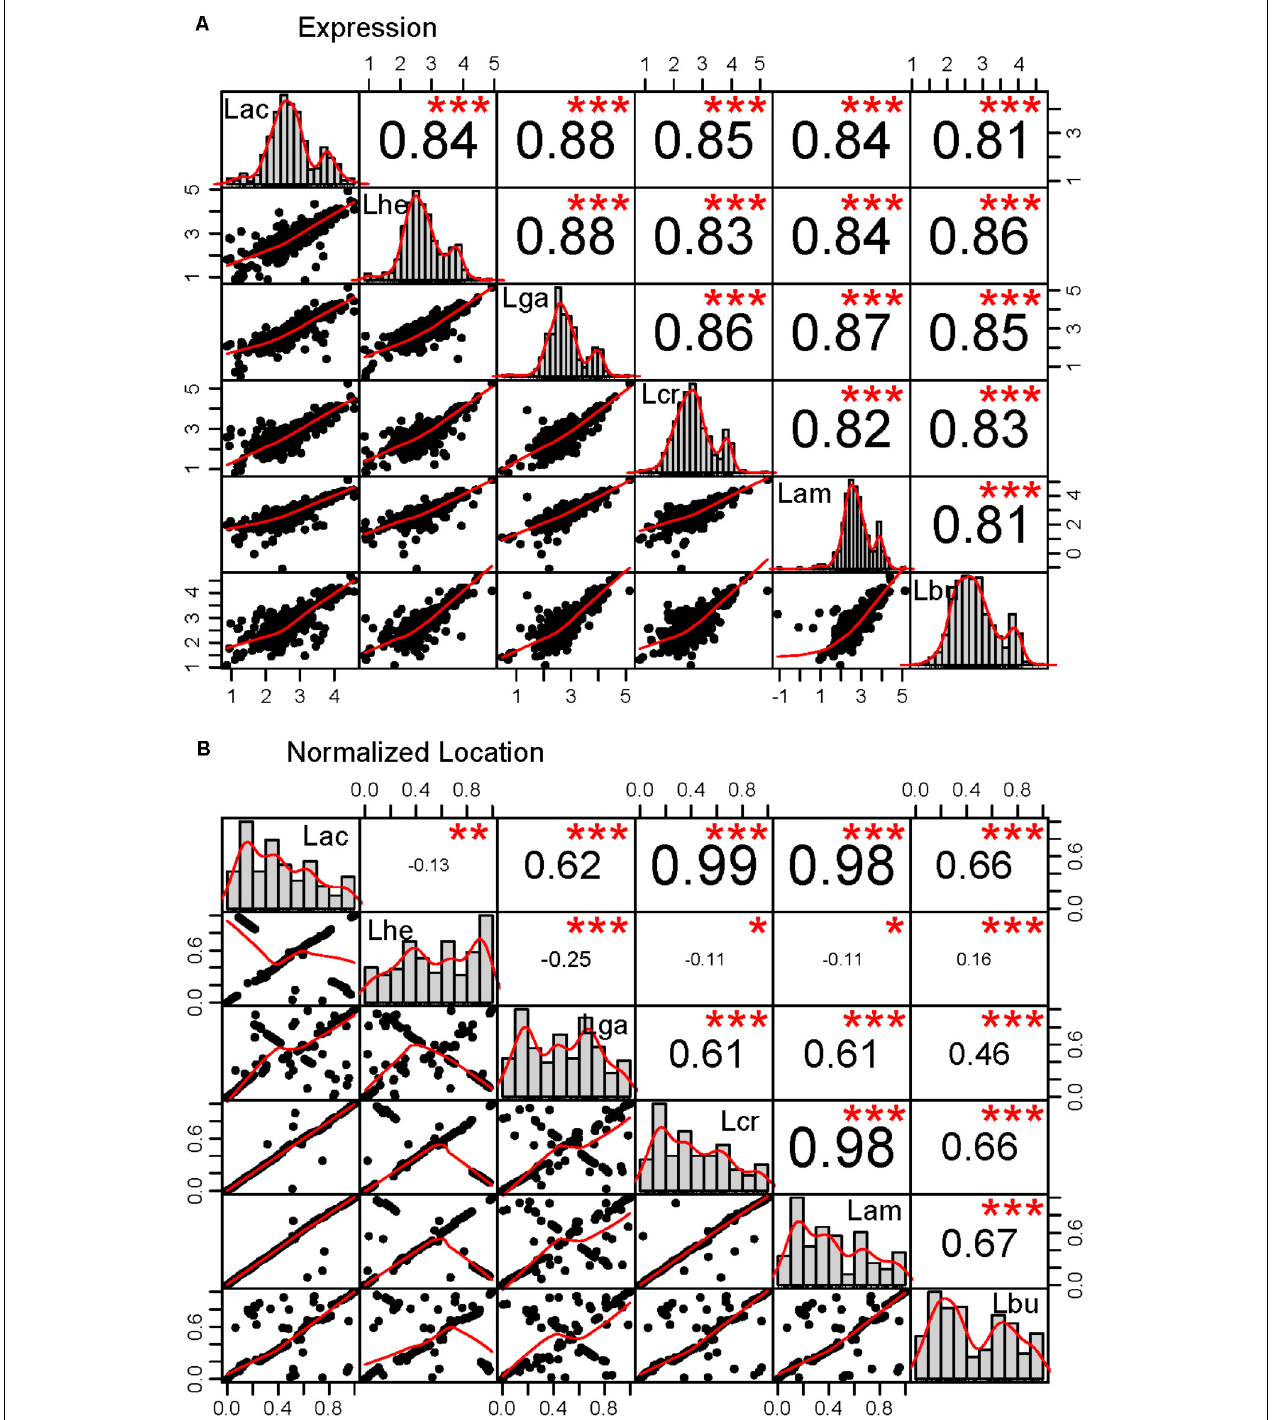
FIGURE 4 | Correlations in the core genome. Correlations were performed for the core genome in all pairs of organisms in two categories: (A) expression as measured by the log 10 transformed RPKM values, (B) location in the genome normalized to account for the length differences in the genomes. The lower left plots show the scatter plot and best fit line for each pairwise comparison. The histograms across the diagonal of each matrix show the distribution of the core genome. The R 2 value for each correlation is given in the upper right boxes and the number of stars depict the statistical significance of the correlation, ( ∗∗∗ p < 0.0001; ∗∗ p < 0.001; ∗ p < 0.05). The three letter code for each organism is as follows: Lac ( L. acidophilus ), Lam ( L. amylovorus ), Lcr ( L. crispatus ), Lhe ( L. helveticus ), Lbu ( L. bulgaricus ), and Lga ( L. gasseri